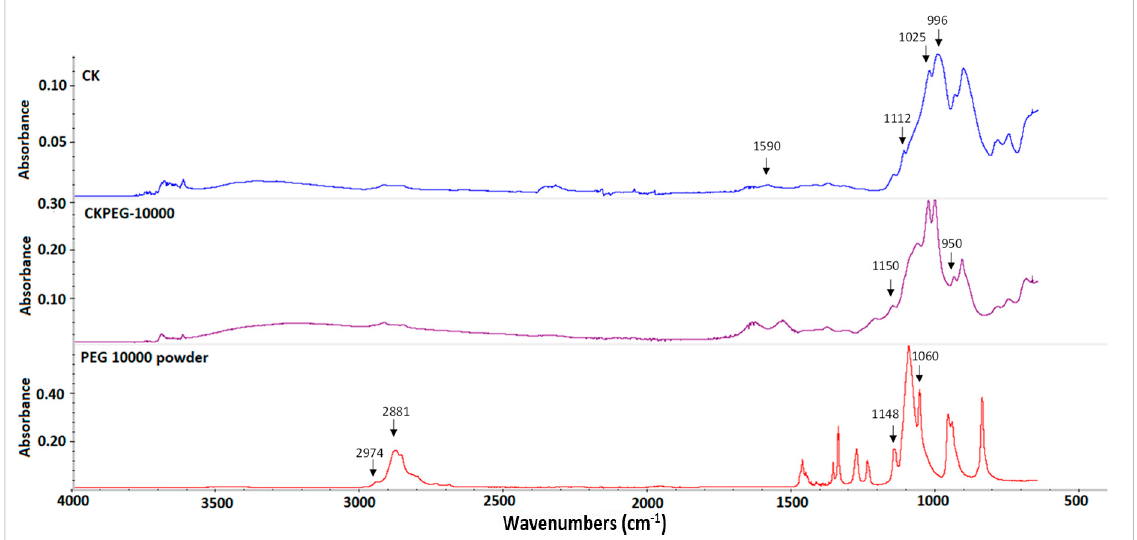
Figure 7. ATR–FTIR spectra of PEG powder, and CK and CKPEG-10000 composite